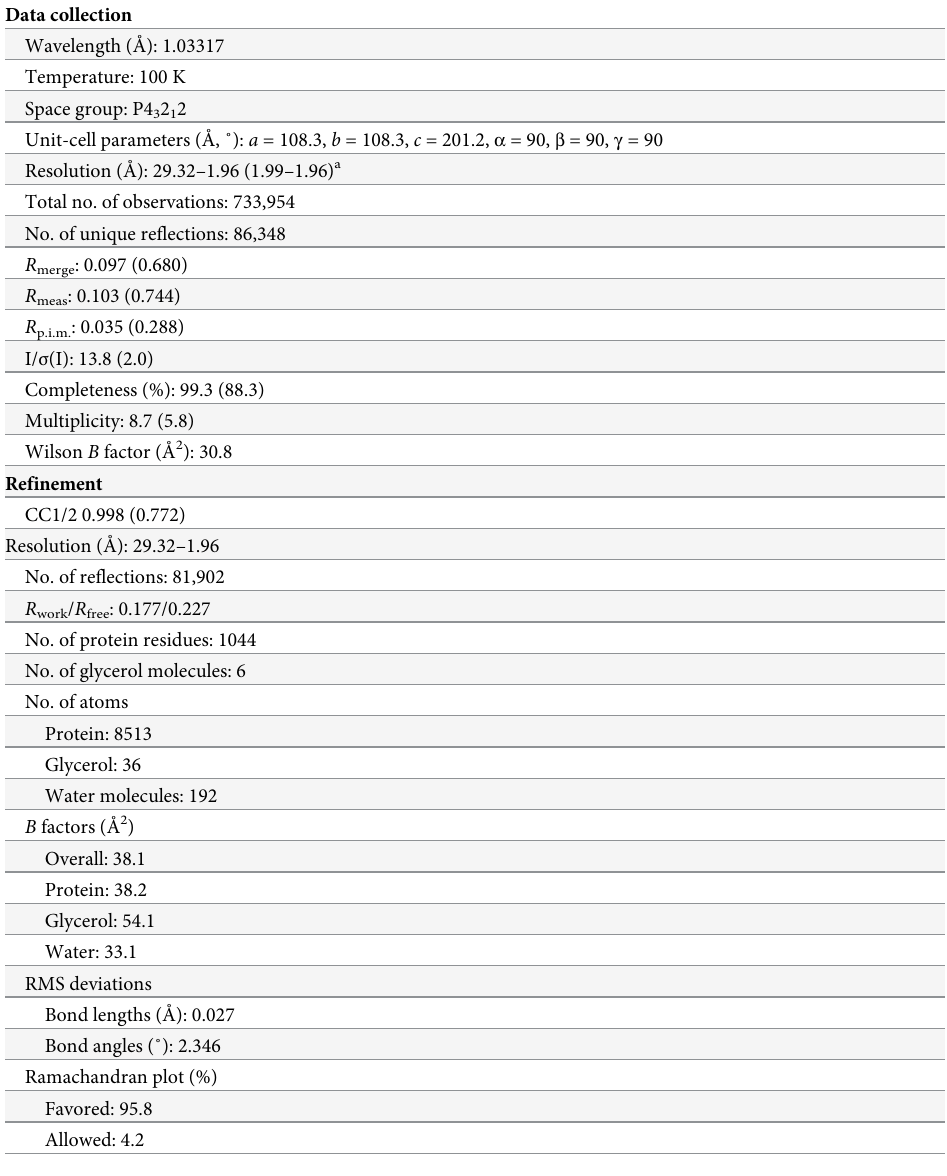
Table 3. Data-collection and refinement statistics for HNL1 (pdb id